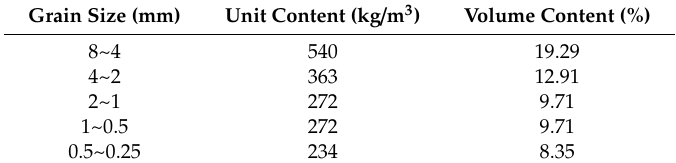
Figure 7. Loading scheme of the concrete specimen.